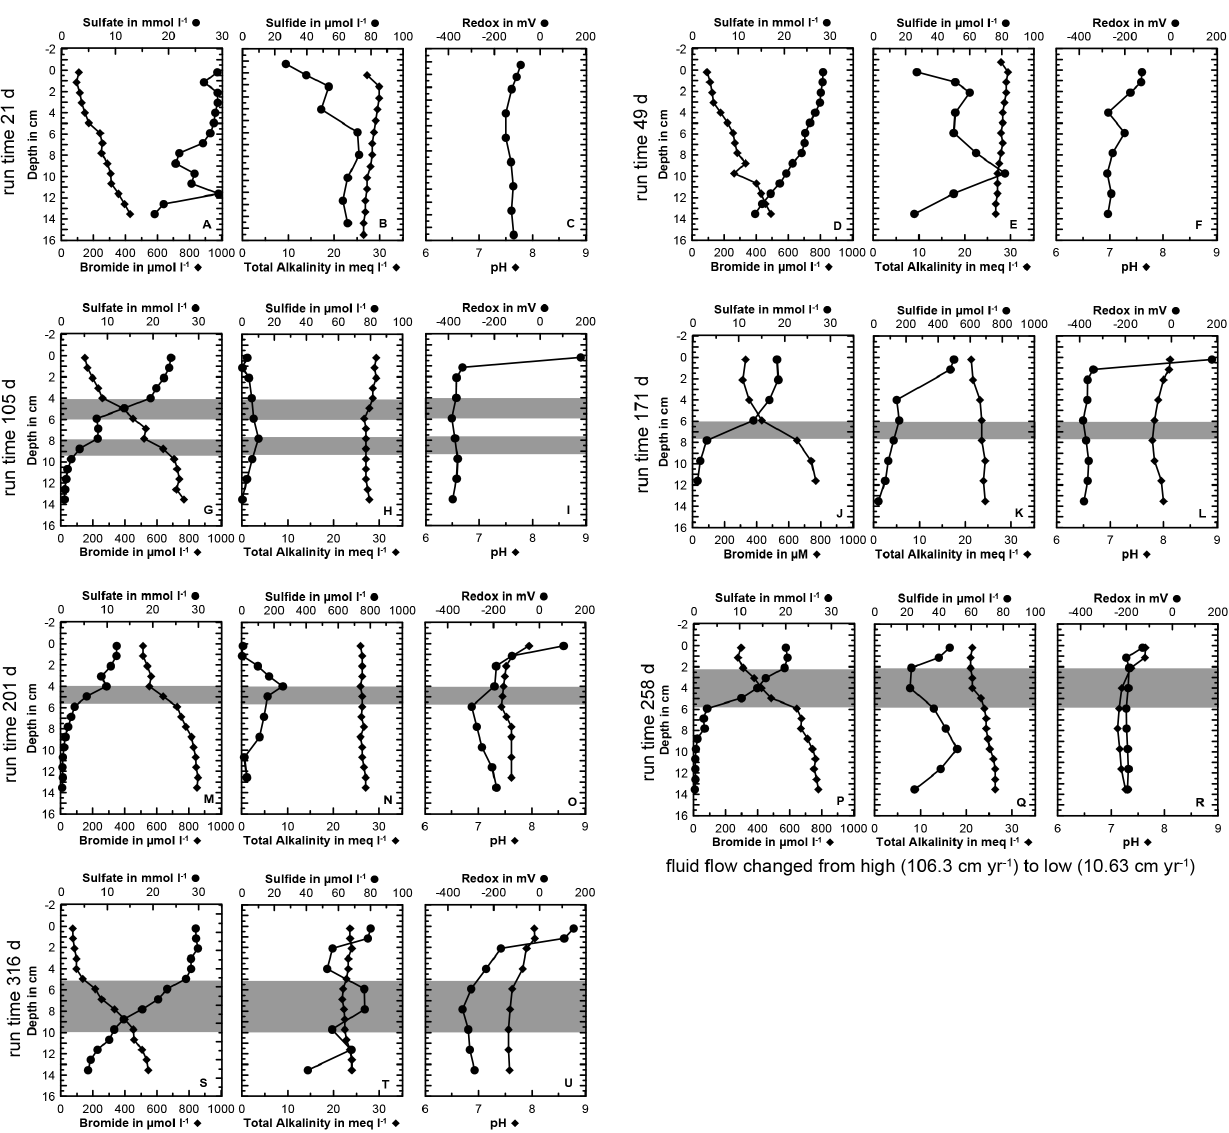
Figure 4. Sulfate and bromide concentrations (left panels), sulfide and total alkalinity concentrations (middle panels), and redox potential and pH (right panels) measured in the sediment of the high-flow regime core (HFC) from Quepos Slide after days of runtime indicated on the left. The SBTZ as proxy for the SMTZ is highlighted by the grey bar. All concentrations are presented as per liter of porewater. Please note the different scales for sulfide